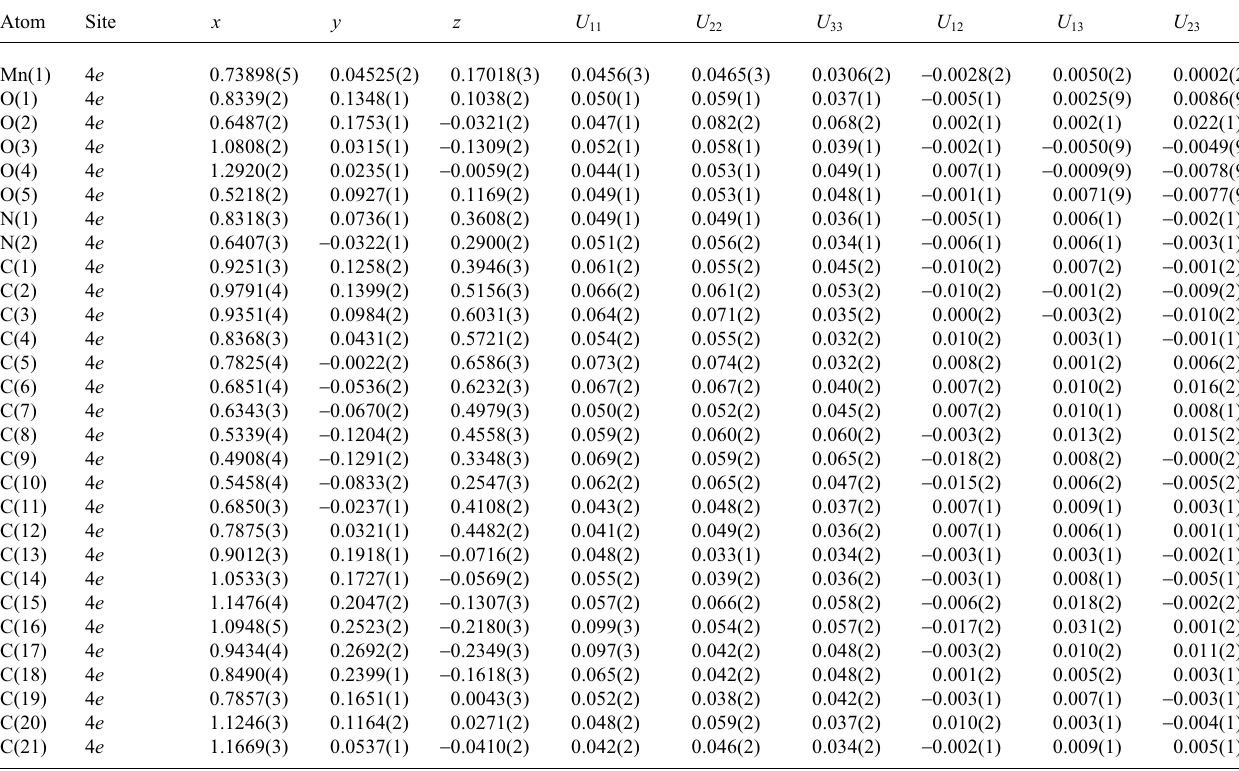
Table 3. Atomic coordinates and displacement parameters (in Å 2 ).